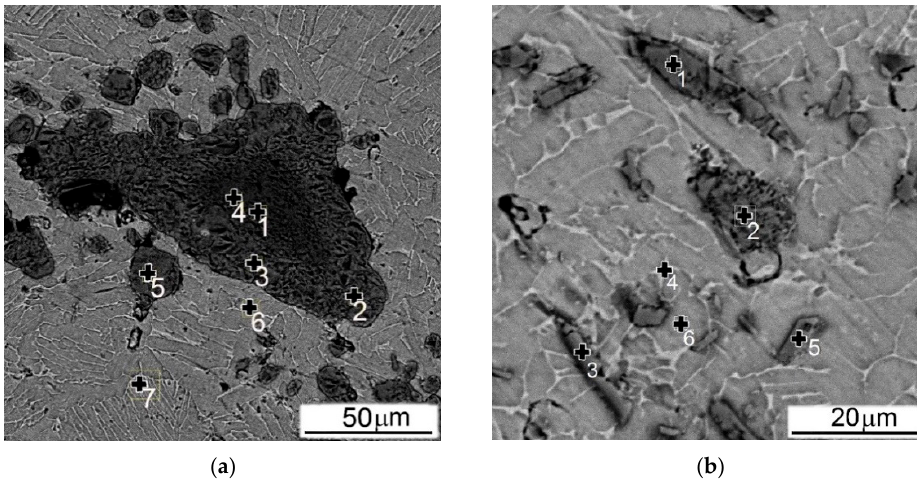
Figure 23. SEM images (BSE) of ( a ) Ti64BEPM + 10TiC and ( b ) Ti64BEPM + 10TiB with the marked locations where the EDS chemical composition point analysis was taken (see results in Table 4) .